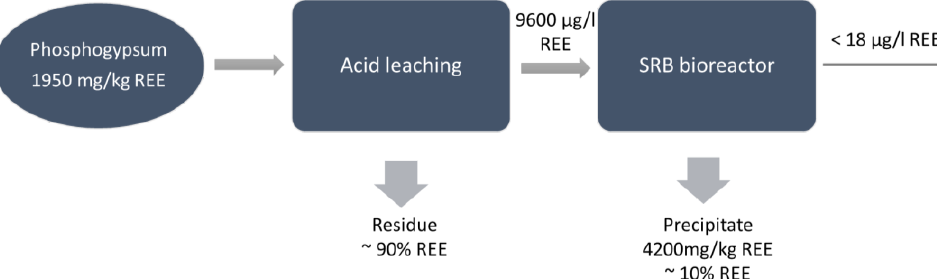
Figure 3. Flow chart for integrated acid leaching and biological sulfate reduction in phosphogyp- for REE recovery sum for REE recovery [26].